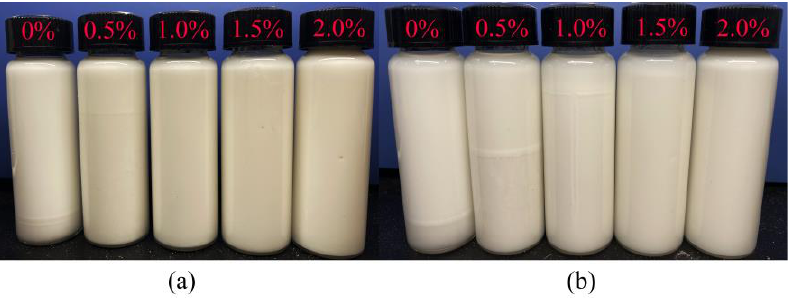
Figure 3. Sedimentation stability of the invert emulsions with different TQ-1 concentrations set for 1 ( a ) and 7 ( b ) days.